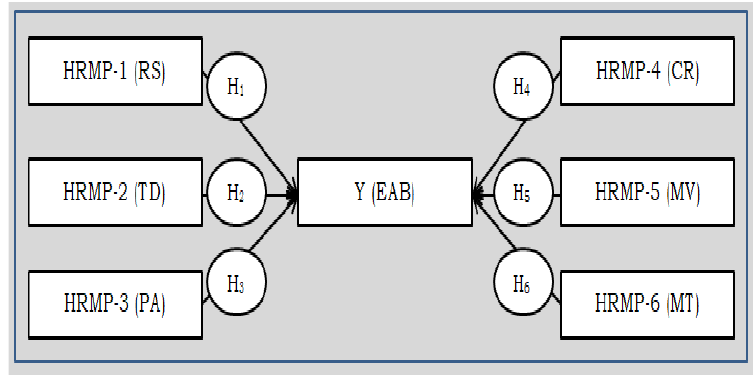
Figure 1 : Conceptual Framework of The